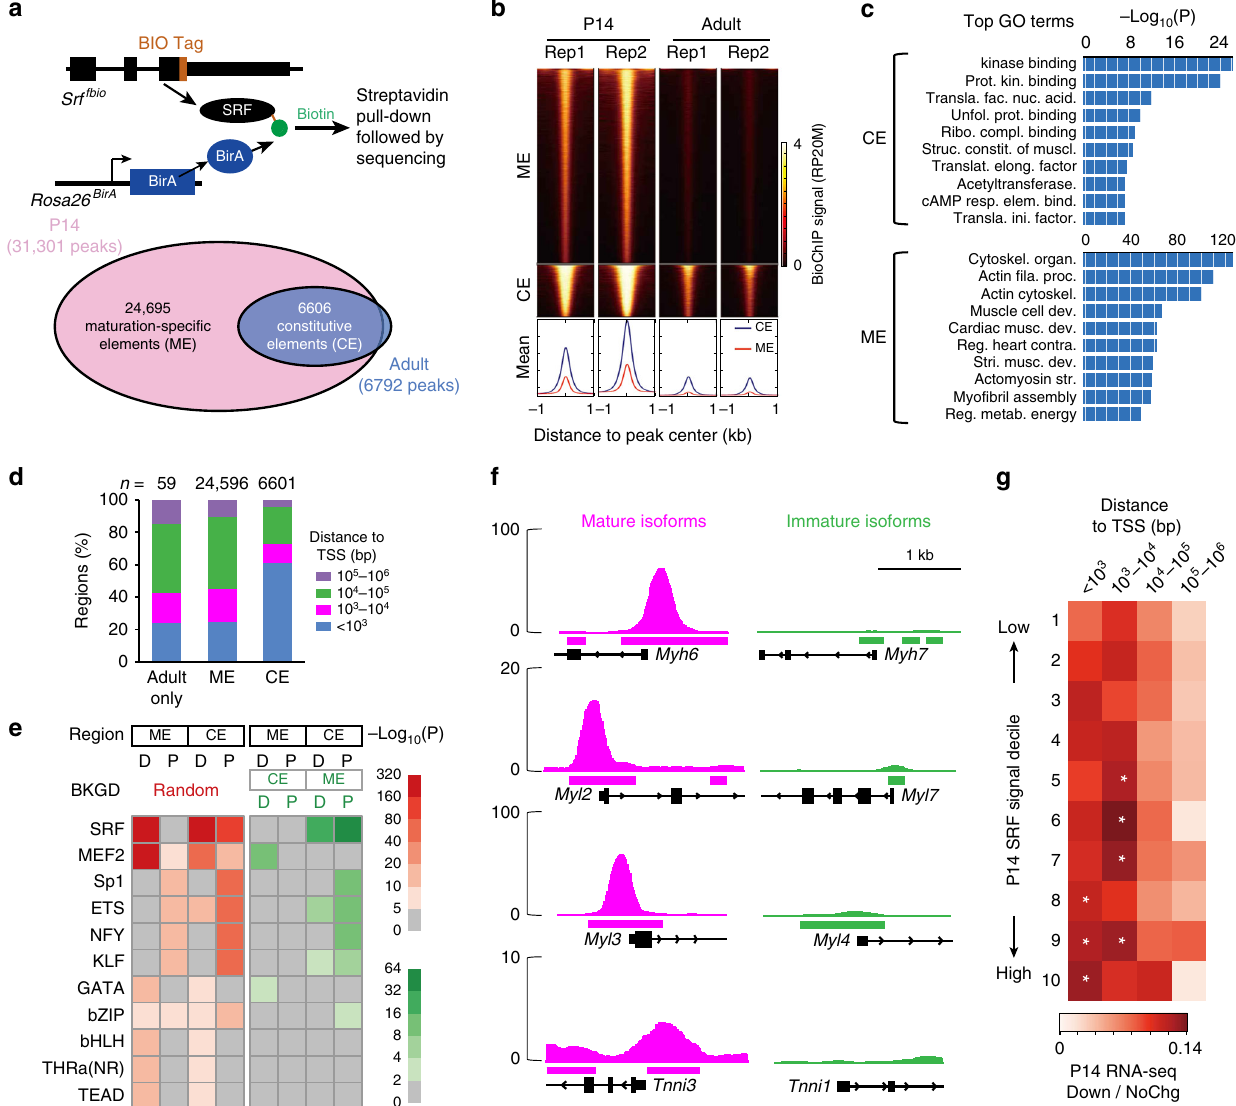
Fig. 4 Stage-speci fi c SRF chromatin occupancy determines its maturation-speci fi c regulation of gene expression. a SRF bioChIP-Seq at P14 and adult stages identi fi ed chromatin regions bound by endogenous SRF in hearts. These regions were grouped into maturation-speci fi c elements (MEs) uniquely present at P14, and constitutive elements (CEs) found at both P14 and adult stages, and adult-only elements. b SRF bioChIP-seq signal on CEs and MEs. Each row shows SRF signal of a genomic region centered on a CE or ME and extending 1 kb upstream and downstream. Plots below show average signal at these regions. c GO term analysis of genes associated with CEs or MEs. d Distance of SRF-bound regions to the nearest transcriptional start site (TSS) for peaks found at P14 only (ME), P14 and adult (CE), or adult only. e Analysis of TF motifs enriched in the central 200 bp of CEs and MEs at proximal (TSS ±1 kb) or distal regions. The 1000 regions with the greatest SRF signal in each group was used for this analysis. Non-redundant motifs with P < 10 – 5 are shown. Left and right panels show enrichment compared to randomly permuted background or the indicated set of comparison sequences, respectively. P values were calculated by Homer 65 using a negative binomial distribution. f SRF bioChIP-seq signal at P14 at four SRF-dependent mature myo fi brillar genes (magenta) and their immature paralogs (green). Called peak regions are labeled as bars below the signal plot. g Relationship between peak distance to TSS, peak SRF occupancy signal, and likelihood of gene down-regulation on SRF knockout. SRF-occupied regions were divided into deciles by SRF bioChIP-seq signal. Color represents the ratio of down-regulated to unchanged genes. One-tailed Fisher's exact test: * P <